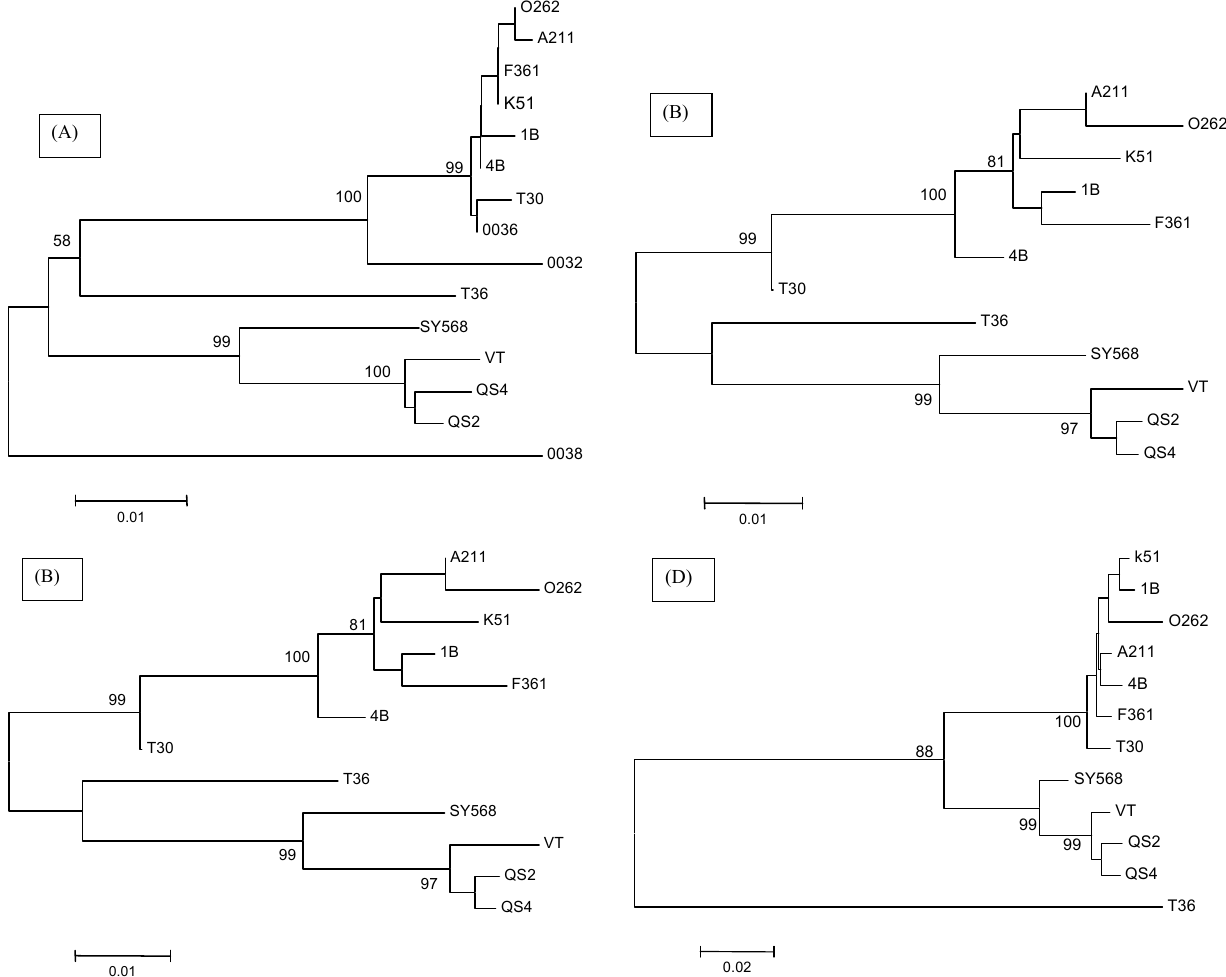
Figure 2. Phylogenetic trees generated by the neighbour-joining method from the alignment of the nucleotide sequences of the major CP (A), P18 gene (B), P20 gene (C) and partial RdRp gene (D) of selected Citrus tristeza virus isolates using MEGA (Version 4.1). Bootstrap values (percentage) for 1000 replicates are indicated at the main branches. Branch length is proportional to number of nucleotide